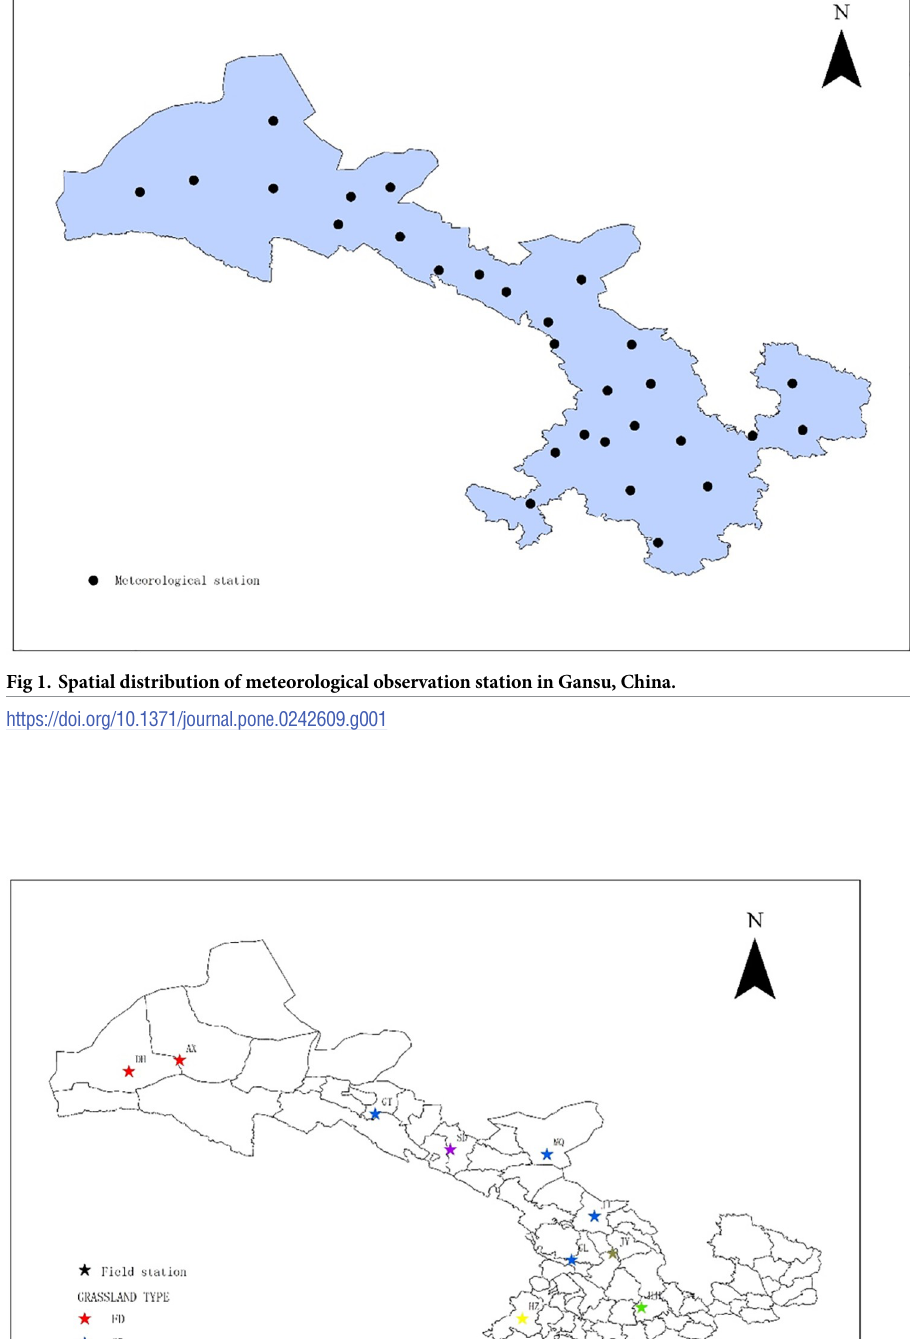
PLOS ONE | https://doi.org/10.1371/journal.pone.0242609 November23,